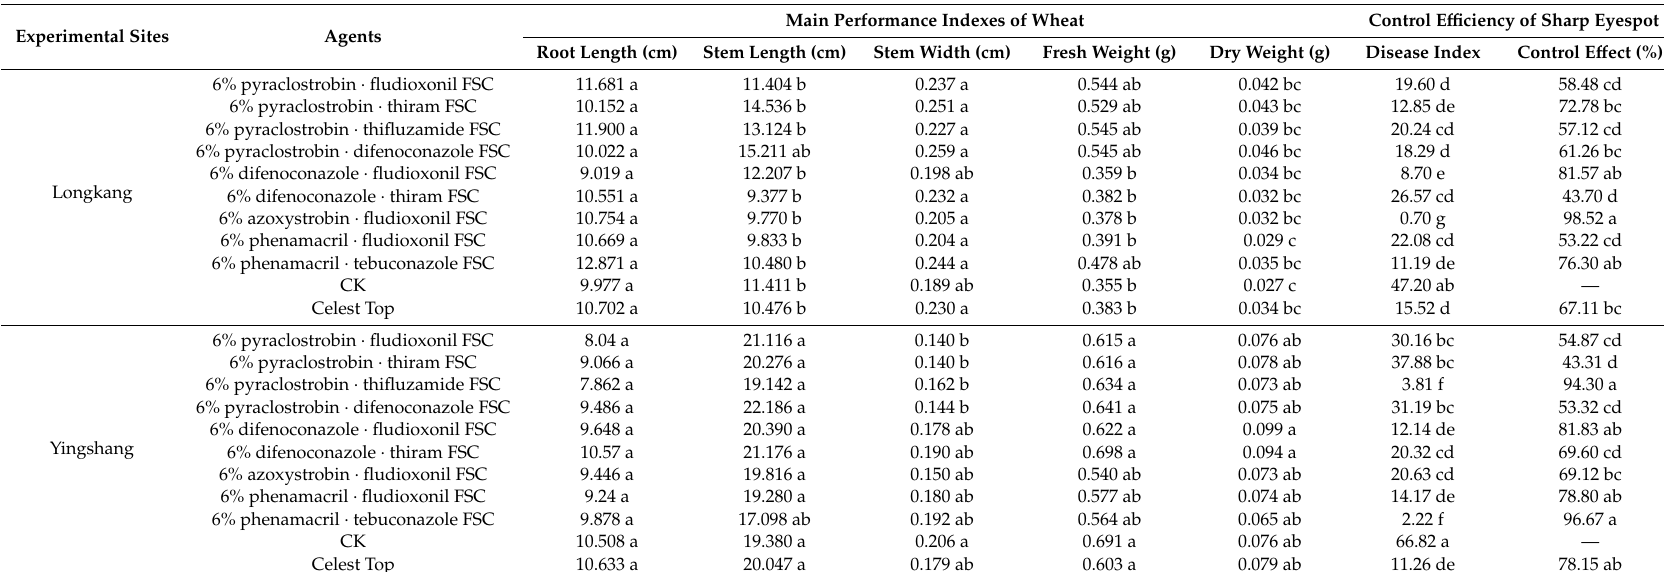
Table 4. The e ff ect of seed coating agents on germination and growth of wheat in field trial. Experimental